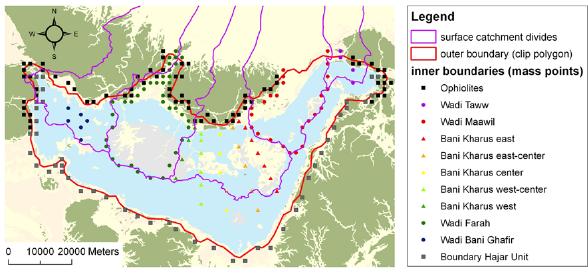
Fig. 6. Data base for fuzzification.